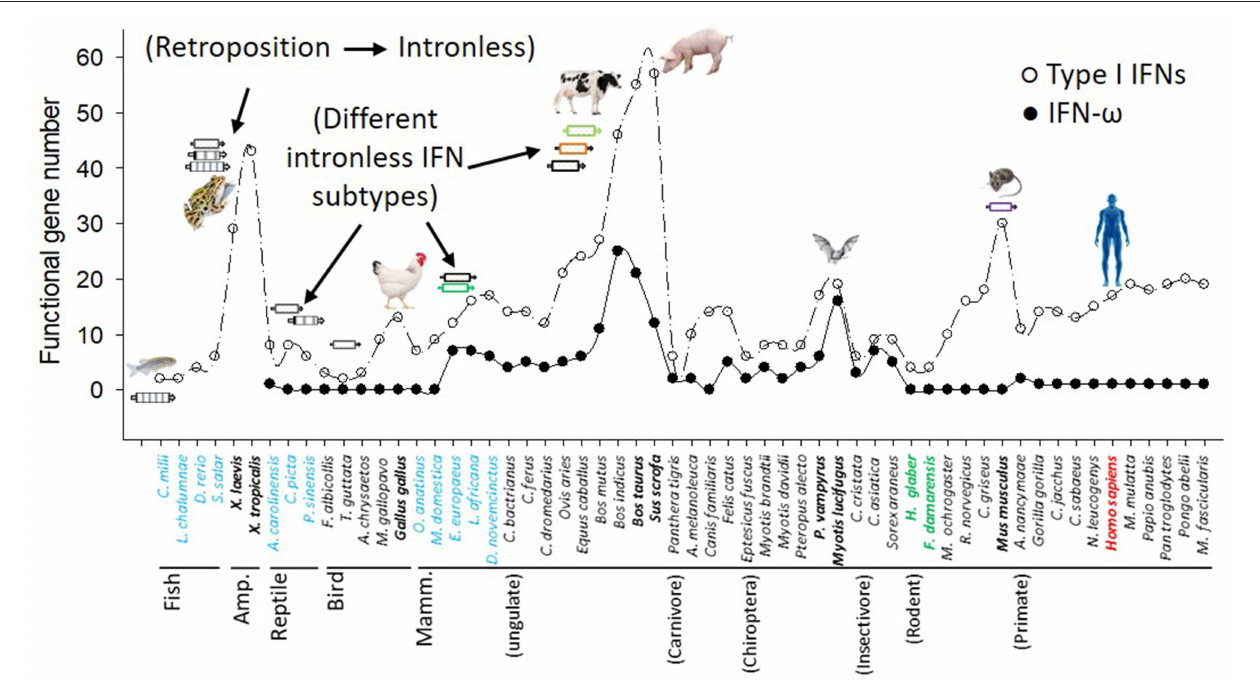
FIGURE 1 | Molecular evolution and diversification of type I IFNs and IFN- ω subtype in representative vertebrate species. Functional IFN gene numbers are annotated from released genomes of representative species and plotted along the phylogenetic order according to NCBI Taxonomy at http://www.ncbi.nlm.nih.gov/Taxonomy. Several major events including the retroposition leading to emergence of intronless IFNs in amphibians, and expansion of IFNs in amphibians, livestock, bats, and mice are shown